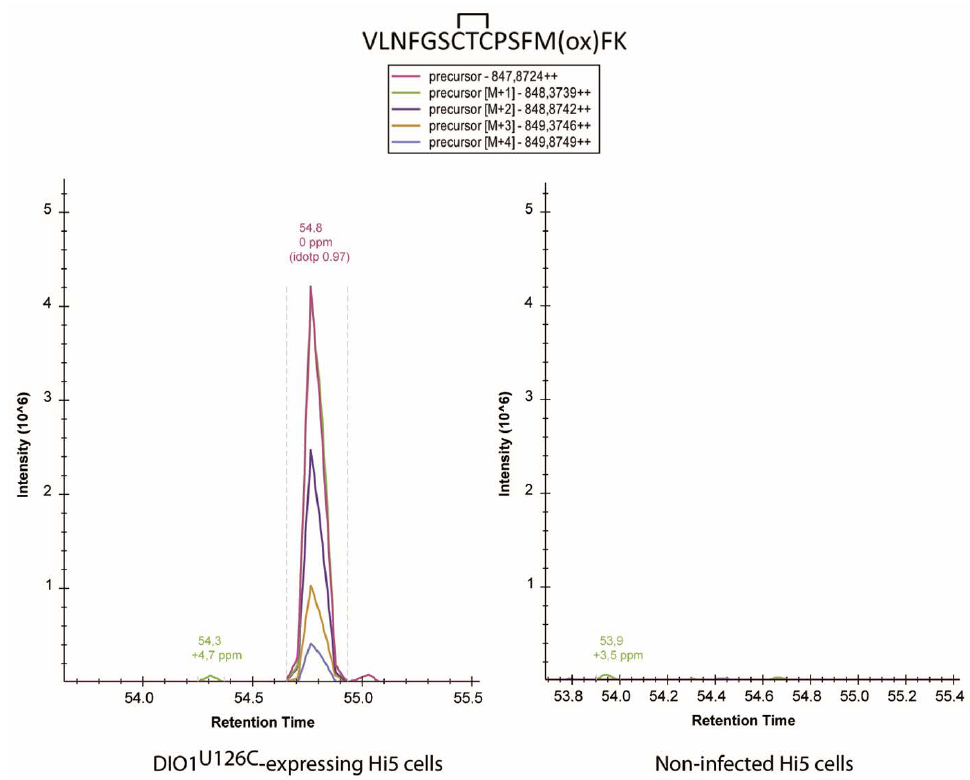
Figure 4. Evidence of an intramolecular disulfide in recombinant DIO1 U126C . Extracted ion chro- matograms of peptide VLNFGSCTCPSFMFK comprising the Cys124-Cys126 disulfide bond in the negative controls (non-transfected Hi5 cells, right panel) and DIO1 U126C -expressing cells (left panel). The figure was obtained using the Skyline